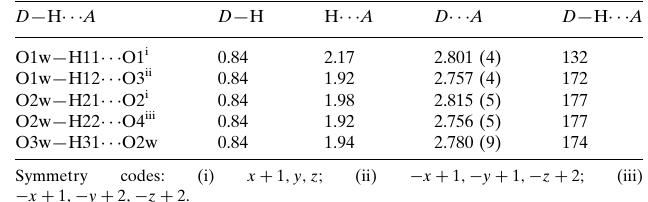
The iminodiacetate dianion in the title compound,